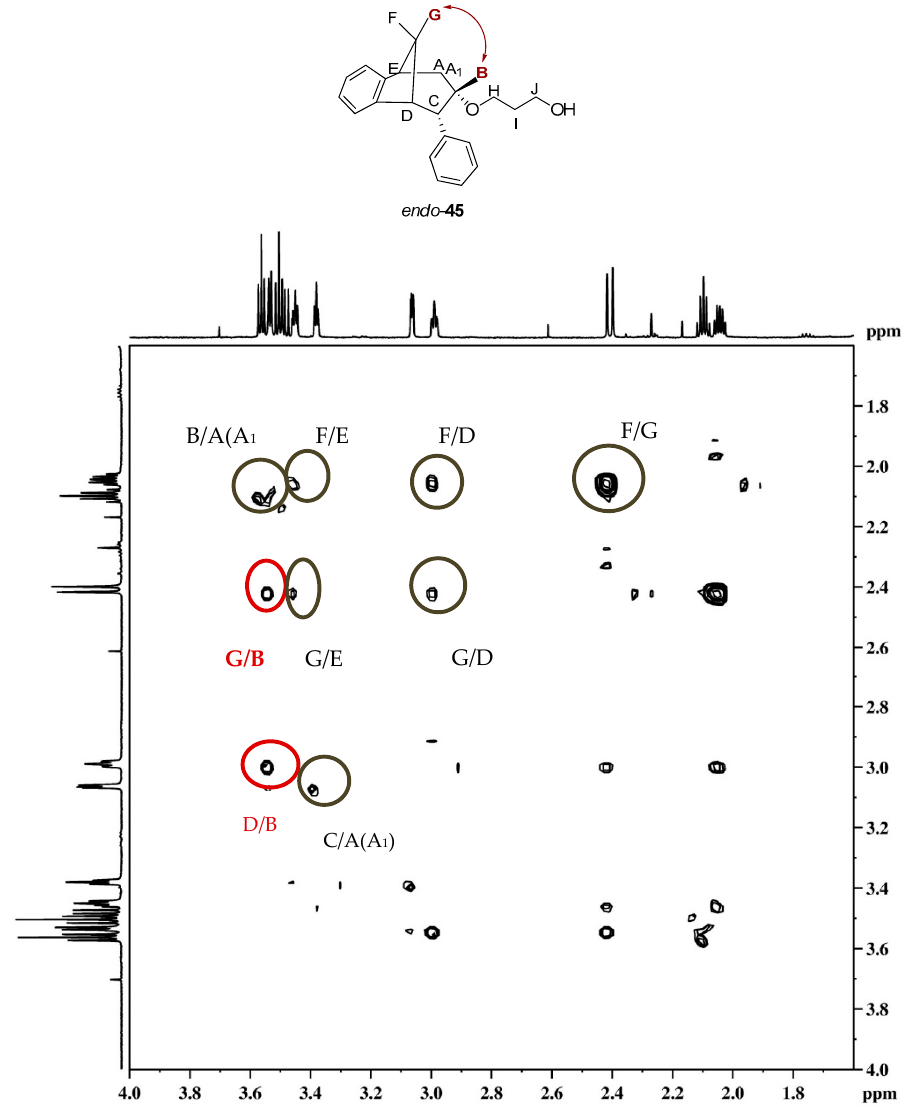
Figure 12. NOESY spectrum of ether endo - 45 .